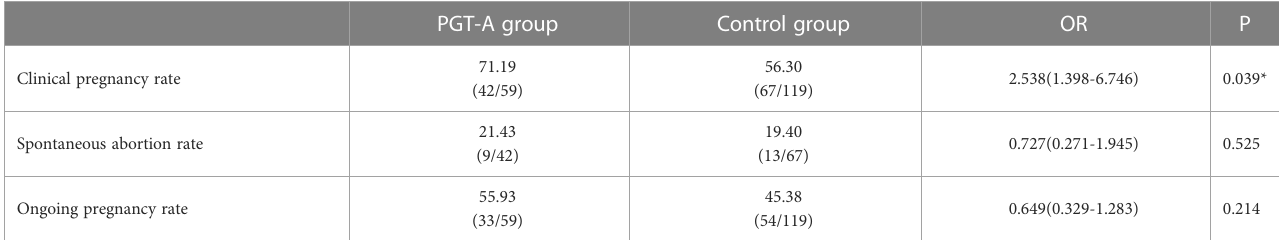
TABLE 3 Clinical outcomes between PGT-A group andontrol